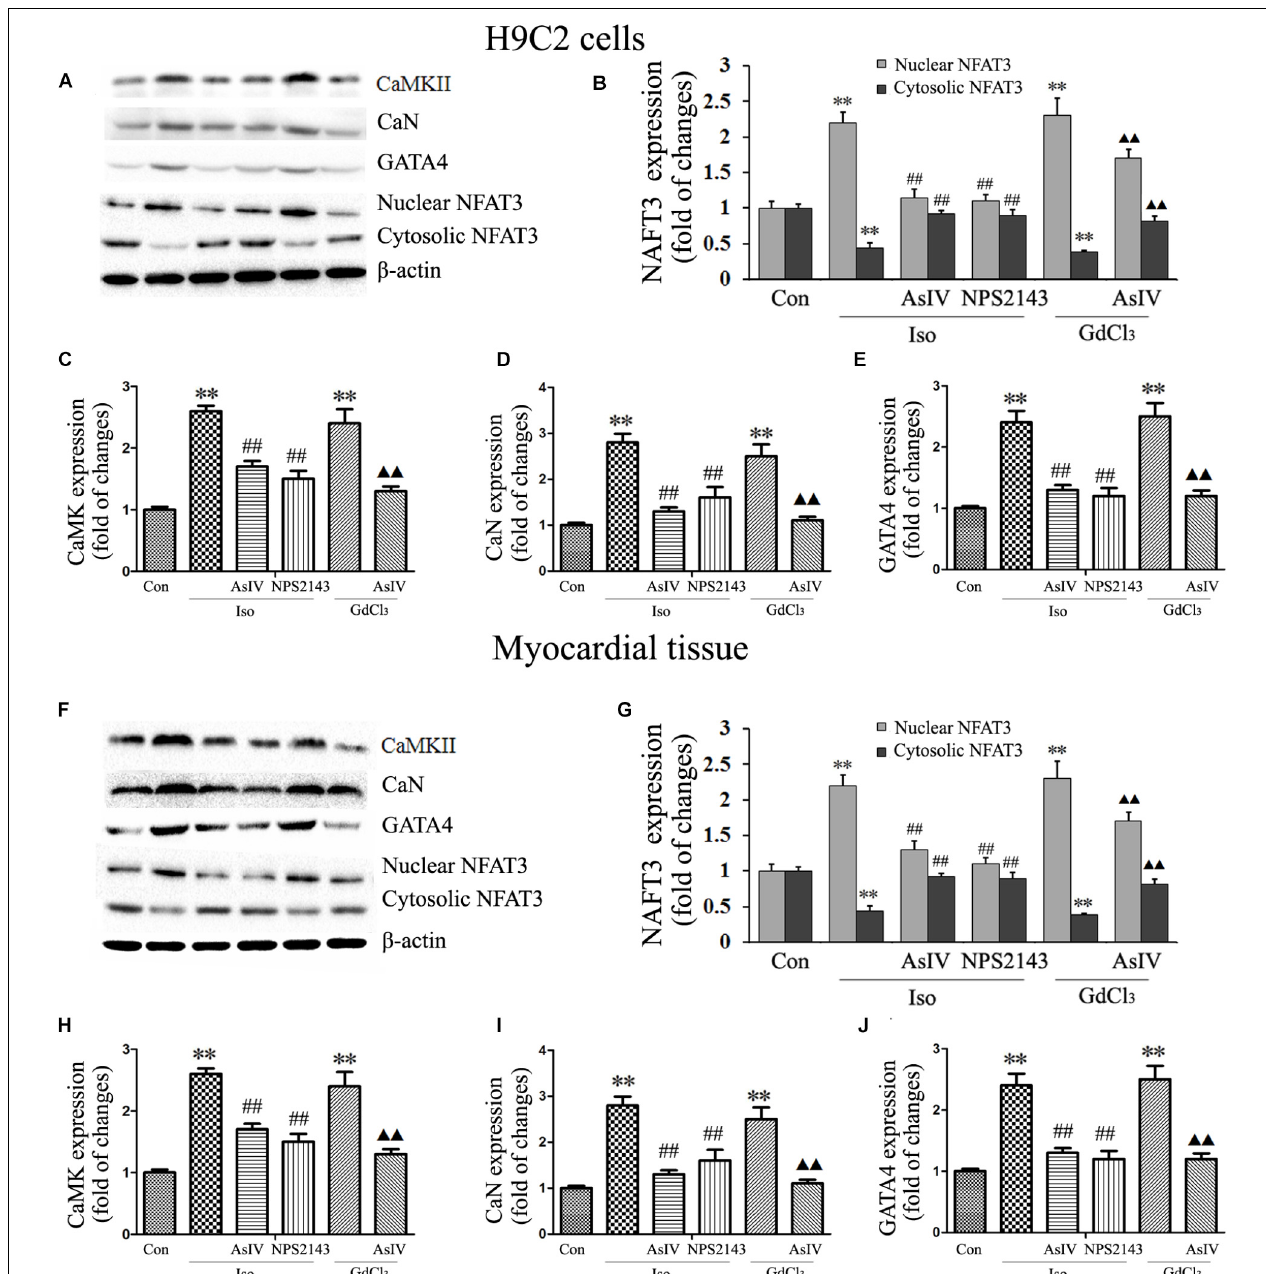
FIGURE 7 | AsIV downregulated the CaMKII and CaN pathways in heart tissue and cells. (A) Representative western blots of CaMKII, CaN, GATA-4 and NFAT-3 in H9C2 cells. (B–E) Statistical data on the protein expression of CaMKII, CaN, GATA-4 and NFAT-3 in H9C2 cells. (F) Representative western blots of CaMKII, CaN, GATA4 and NFAT-3 in myocardial tissues. (G–J) Statistical data on the protein expression of CaMKII, CaN, GATA-4 and NFAT-3 in myocardial tissues. The data are expressed as the means ± SEM, n = 4. ∗∗ P < 0.01 vs. the Con group; ## P < 0.01 vs. the Iso group; and (cid:78) P < 0.05, (cid:78)(cid:78) P < 0.01 vs. the GdCl 3 group.